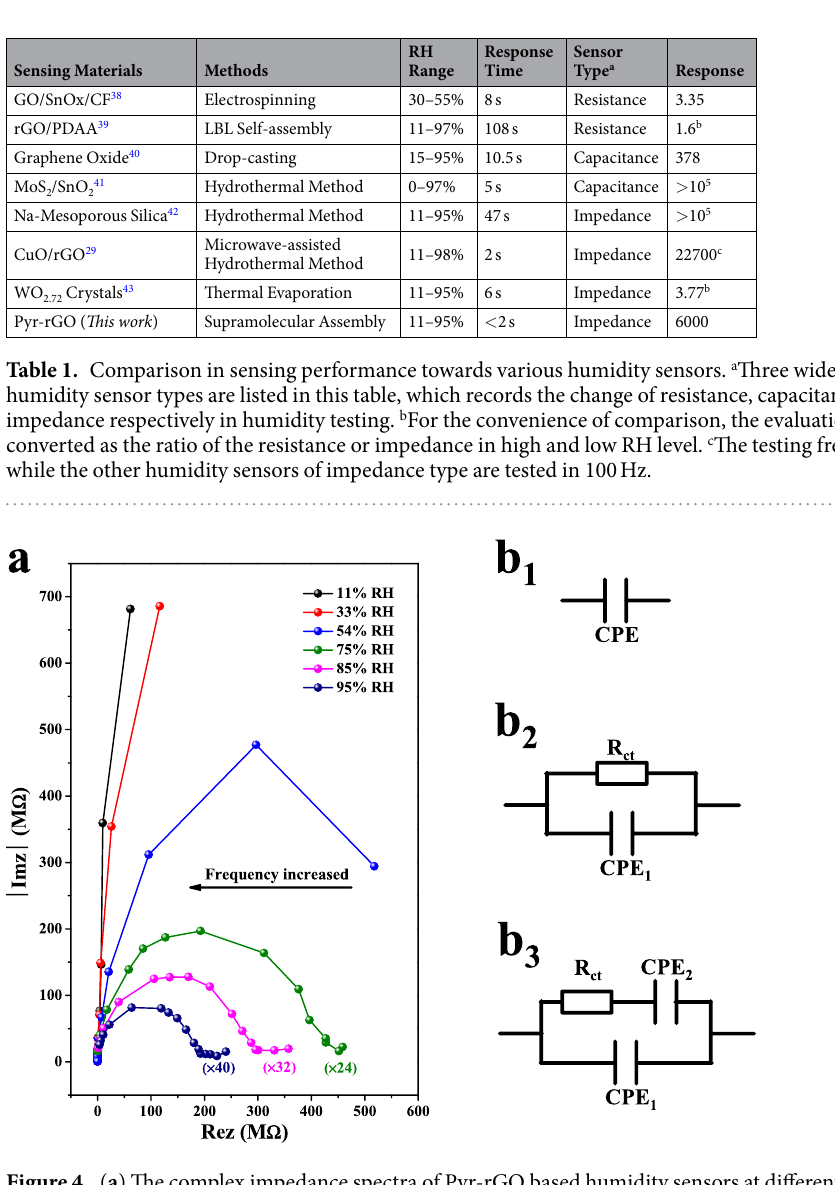
Figure 4. ( a ) The complex impedance spectra of Pyr-rGO based humidity sensors at different RH levels. ImZ: imaginary part; ReZ: real part. ( b ) The equivalent circuit at (b 1 ) low (b 2 ) middle and (b 3 ) high RH